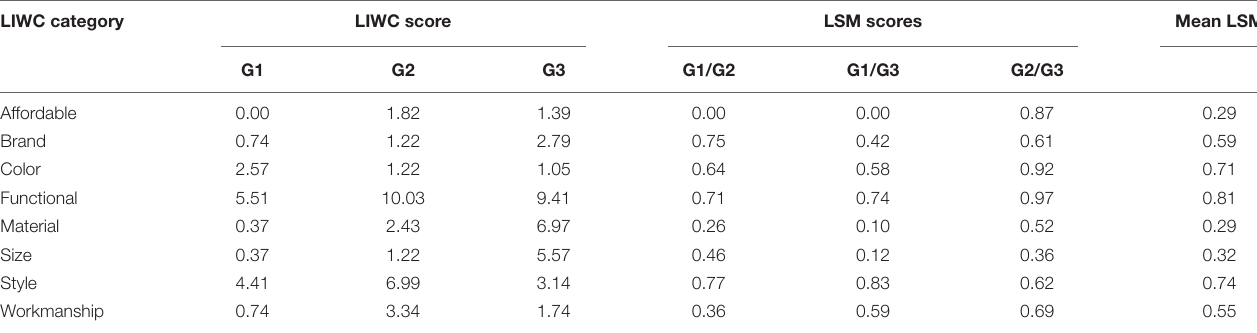
TABLE 3 | Sample LSM for online review of female garments.